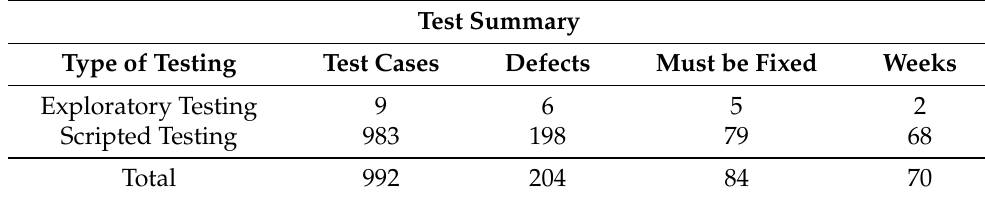
Table 1. Summary of test